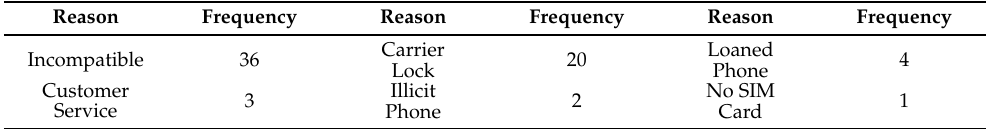
Table 17. Complaints to